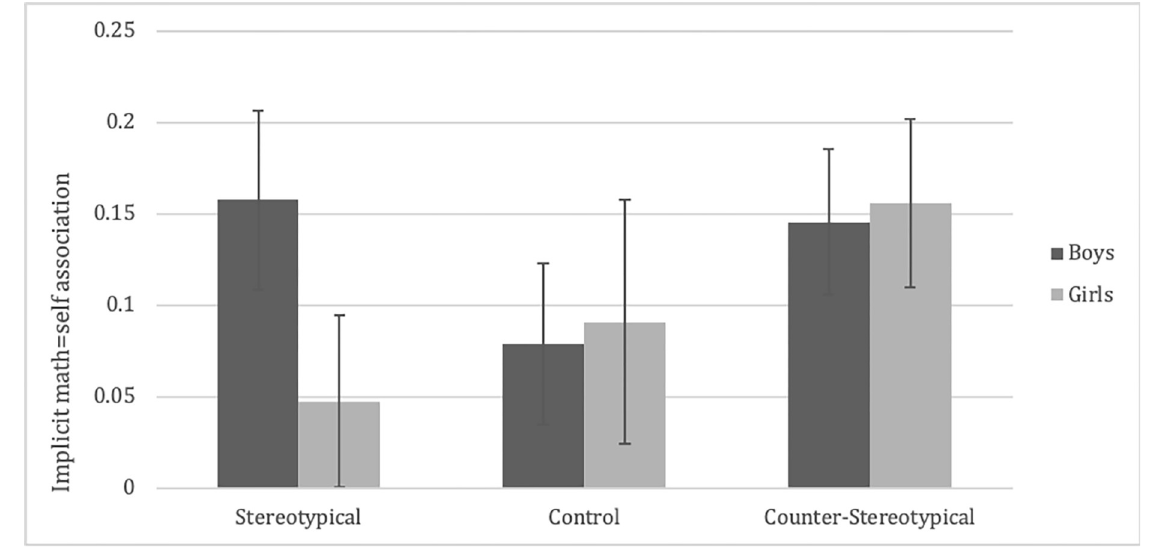
Fig 5. Implicit self-concept by condition and gender. Error bars represent standard